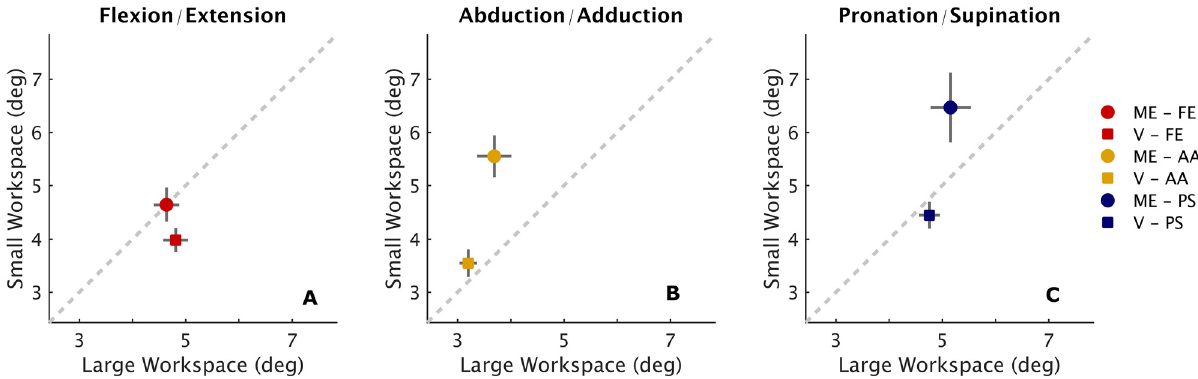
Fig 5. Differences between performance in large workspace (LSW) and small workspace (SWS) for flexion/extension (A), abduction/ adduction (B) and pronation/supination. Errors which fall below the 45° line (equality line) indicate a worst performance in the LWS, whereas values which fall above the equality line indicate decrement in accuracy/precision in the SWS condition. Data points that fall directly on the equality line indicate that performance is equal in the two